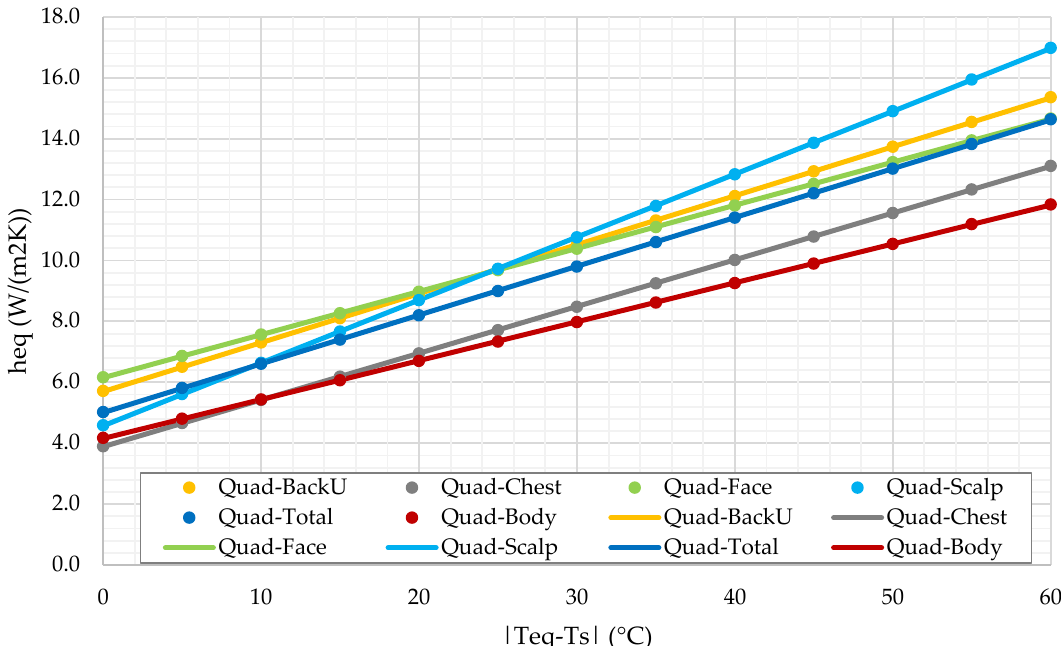
Figure 9. h eq linear relation for body segments group 2.